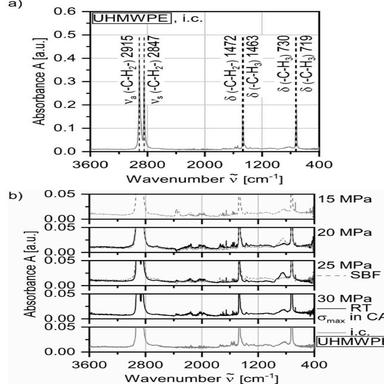
Fourier-transform infrared spectroscopy (FTIR) traces on UHMWPE: a) in initial condition (i.c.), b) summarised for all scans after the respective constant amplitude test (CAT).